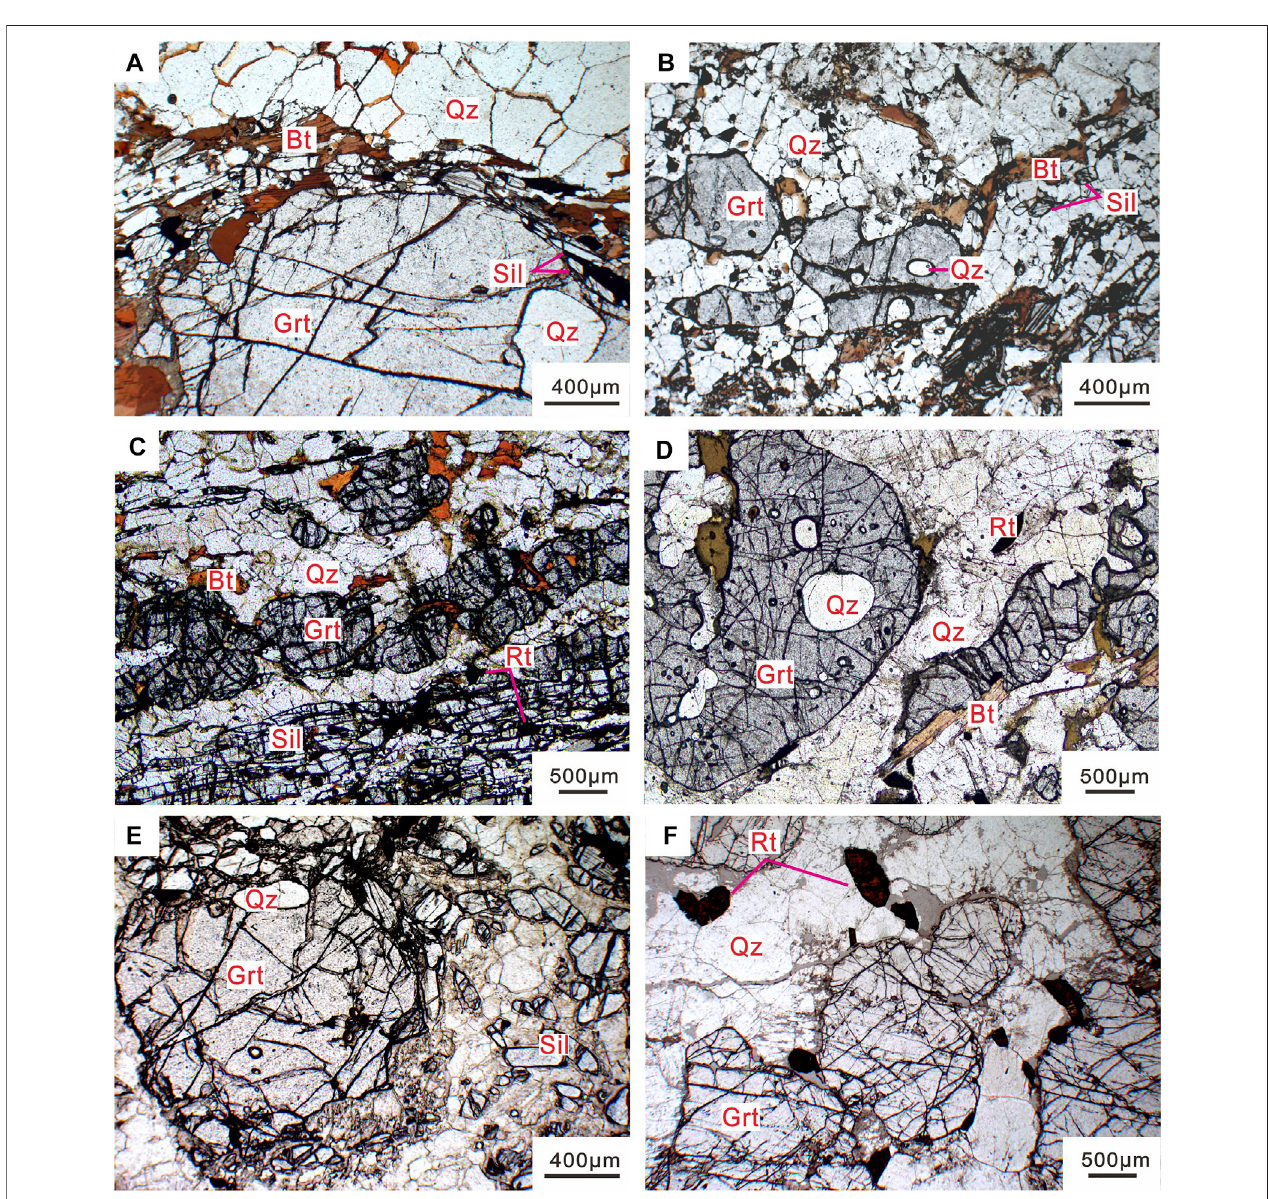
FIGURE 3 | Photomicrographs showing the typical mineral assemblages and quartz micro-textures of samples from the eastern Khondalite Belt, North China Craton. (A) Quartzoccursasinclusionsinrimsofcoarse-grainedgarnet,andinthematrixfromGrt-Sil-Btgneiss(sample20HL64); (B) Quartzisincluded by fi ne-grained garnetandoccursinthematrixfromGrt-Sil-Btgneiss(sample20HL39); (C) Quartzoccursinthematrixfrom fi ne-grainedGrt-Sil-Btgneiss(sample20HL19),theoriented arrangement of sillimanite de fi nes the foliation; (D) Quartz occurs as inclusions in rims of coarse-grained garnet, and in the matrix from Grt-Bt gneiss/granulite (sample 18LC21), with rutile in the matrix; (E) Quartz occurs as inclusions in rim of coarse-grained garnet, and in the matrix from Grt-Sil gneiss (sample 20HL123); (F) Garnet occurs as porphyroblast with quartz and rutile in the matrix from garnet-bearing gneiss/granulite (sample 09XH21). Mineral abbreviations follow Warr (2021).